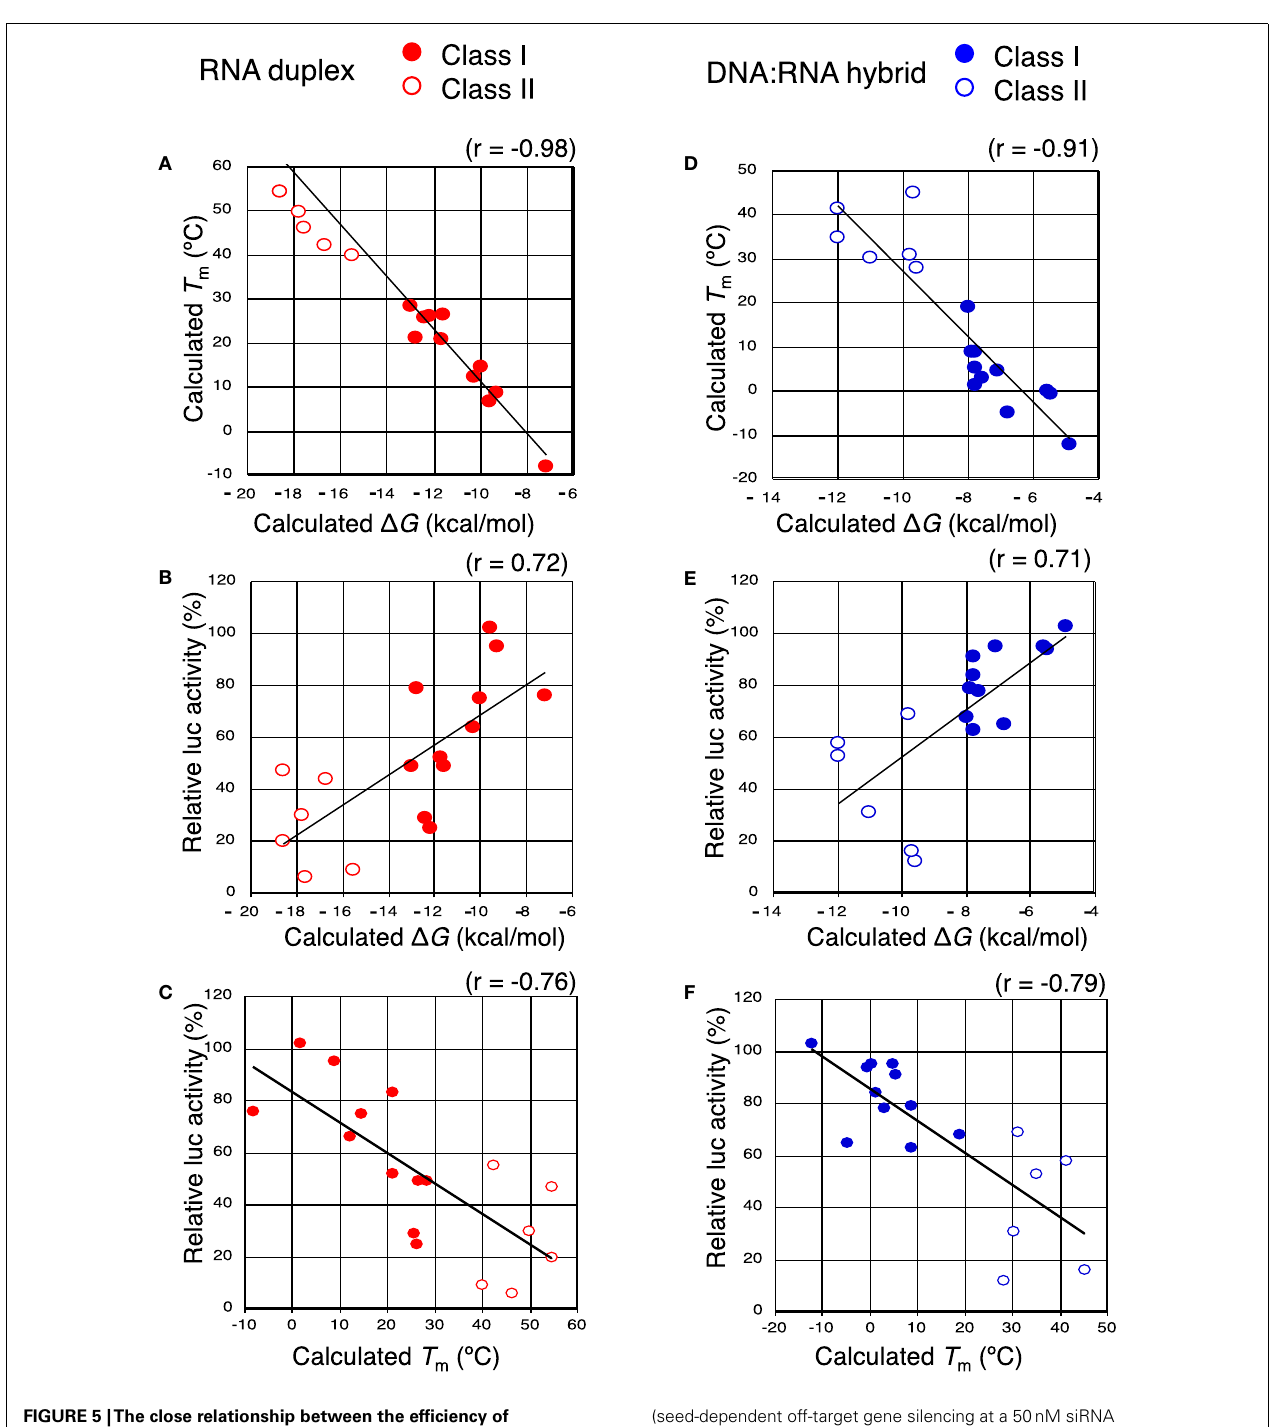
FIGURE 5 |The close relationship between the efficiency of seed-dependent off-target gene silencing and seed-target duplex thermodynamic stability. Both class I siRNAs and functional class II siRNAs (A–C) and class I chiRNAs and functional class II chiRNAs (D–F) were analyzed. Solid red circles and open red circles represent the class I and II siRNA data, respectively. Solid blue circles and open blue circles represent the class I and II chiRNA data, respectively. (A,D) The calculated T m of the seed-target duplex decreased with increasing standard free energy ( Δ G ) for seed-target duplex formation (correlation coefficient: − 0.98 and − 0.91, respectively). (B,E) Luciferase activity